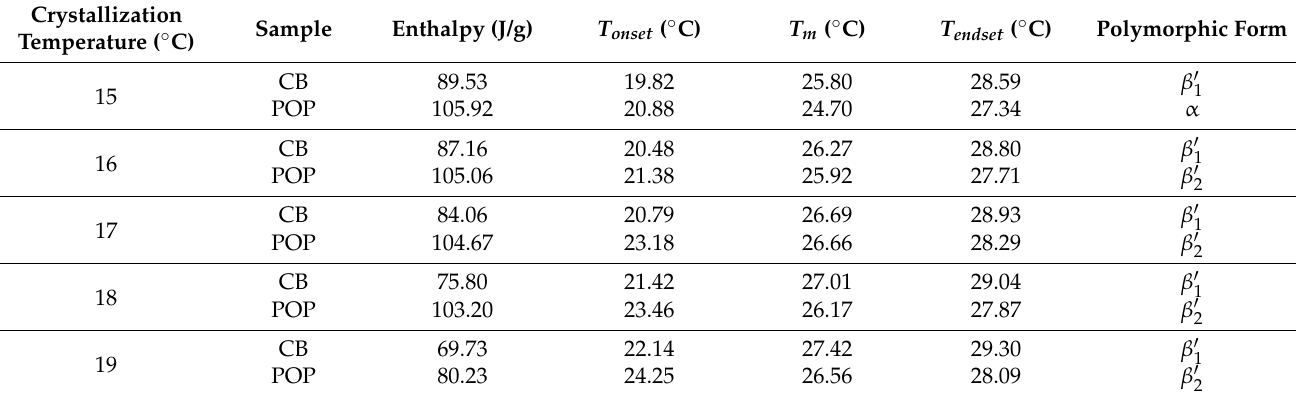
Table 5. Polymorphisms of CB and POP standard at different T c .